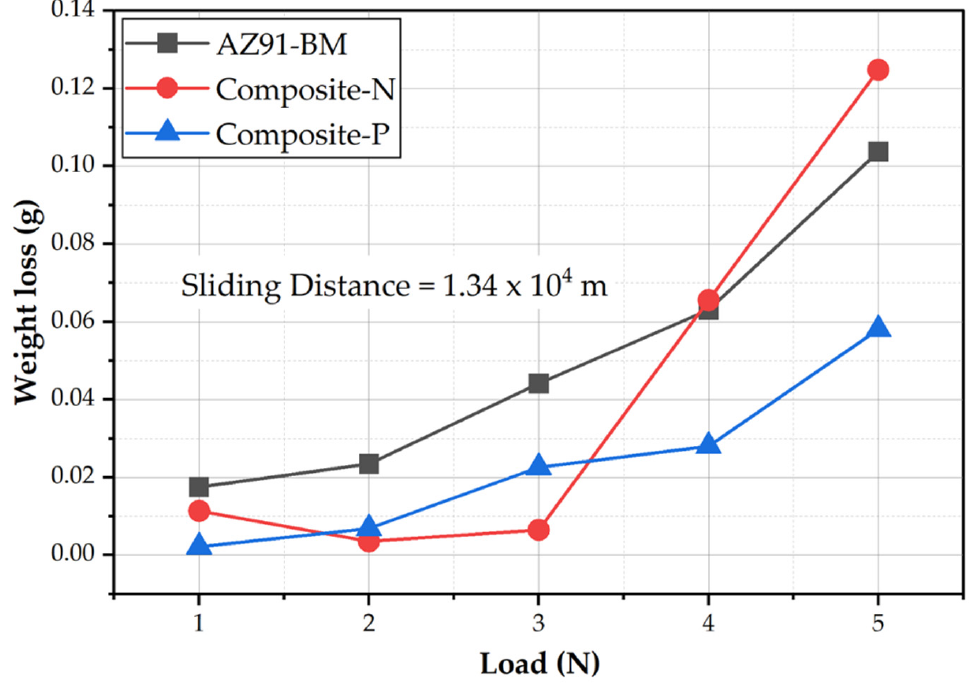
Figure 6. Weight loss against the applied wear loads for AZ91-BM and composite specimens wear- tested at a constant sliding distance of 1.34 × 10 4 m. tested at a constant sliding distance of 1.34 × 10 4